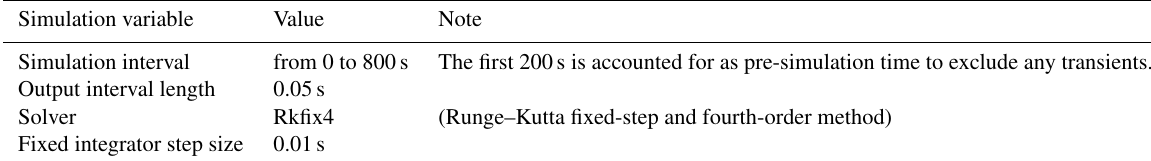
Table 6. Simulation